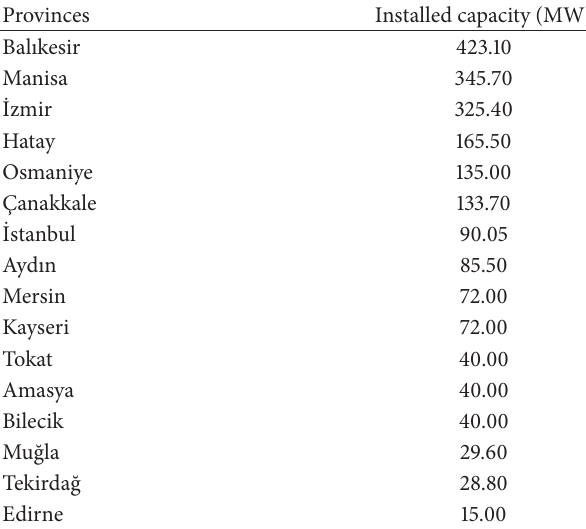
Table 6: Electricity generation costs by fuel type (cent/kWh).